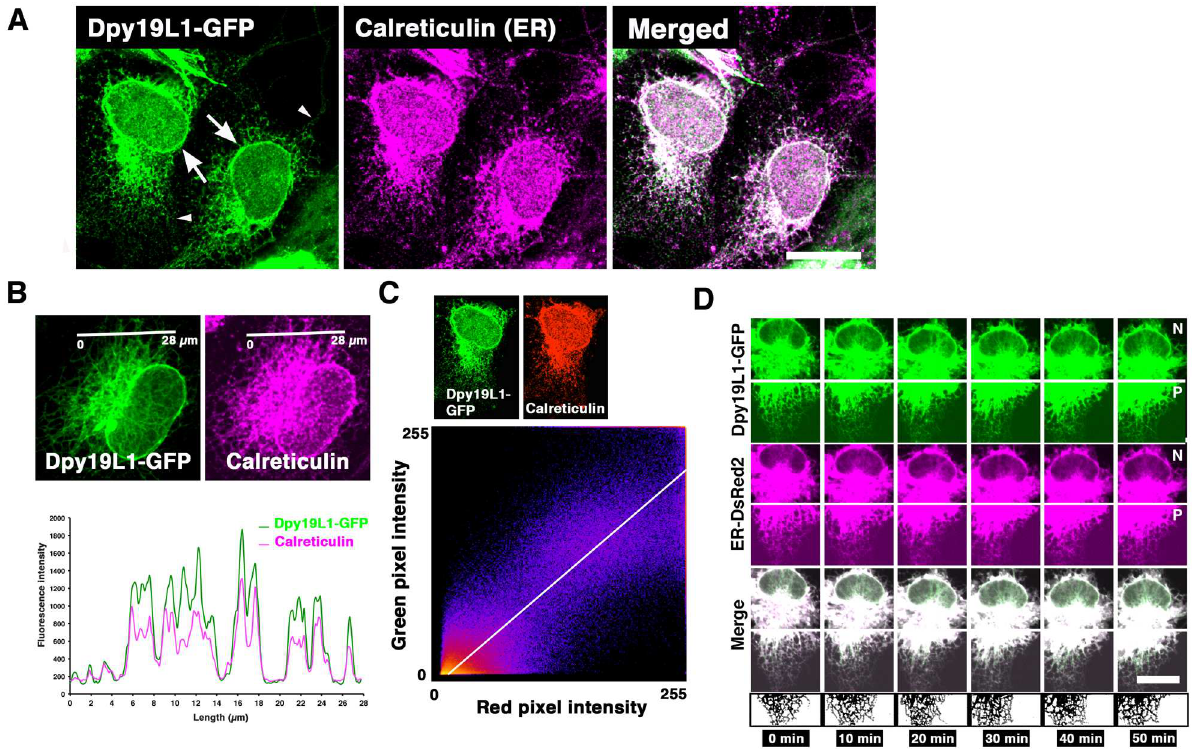
Fig 1. Endoplasmic reticulum (ER) localization of Dpy19L1 in COS-7 cells. COS-7 cells were transfected with a Dpy19L1-GFP plasmid. After 24 h, the subcellular localization of Dpy19L1was observedby immunofluorescencefor GFP and Calreticulin, a marker for the ER. (A) Confocalimages of Dpy19L1-GFP (green)and Calreticulin (magenta). Right panel is the merged image. Dpy19L1-GFP shows a similar pattern with Calreticulin. Arrows indicate localization of Dpy19L1aroundthe nucleus. (B) Doublestaining of Dpy19L1and Calreticulin. Lower image indicatesintensity profile analysisalong a white line in the upper images. (C) Colocalization analysis. An example of scatter plot of red and green pixel intensities of the Dpy19L1-GFP/Calreticulin double-labeled cell shown in Fig 1A. Intensities were measuredfrom fifteen COS-7 cells. (D) Dynamics of Dpy19L1and the ER were observedby time-lapse imaging. The movies are shown in S1 and S2 Movies. COS-7 cells were transfected with a Dpy19L1-GFP plasmidtogether with pER-DsRed2. Upper and lower images show perinuclear(N) and peripheral (P) regions, respectively.Time-lapse images were recordedfrom twenty-five COS-7 cells. Results shown are representativeof at least three independent culture experiments. Scale bars: 20 μ m in A and C.